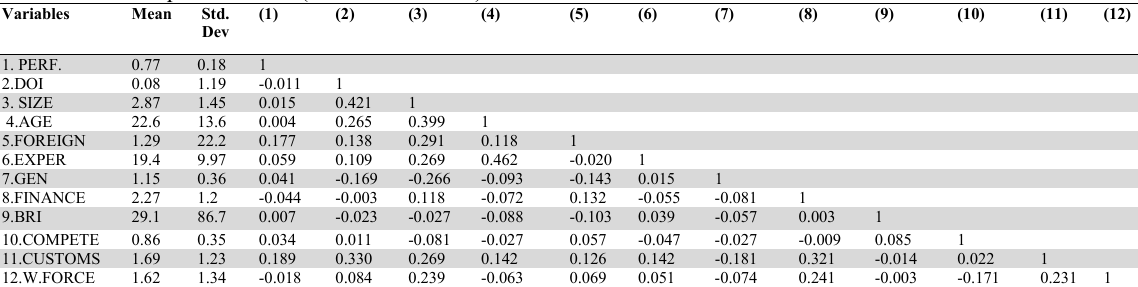
Matrix correlation pair variables (Bivariate Pearson) Variables